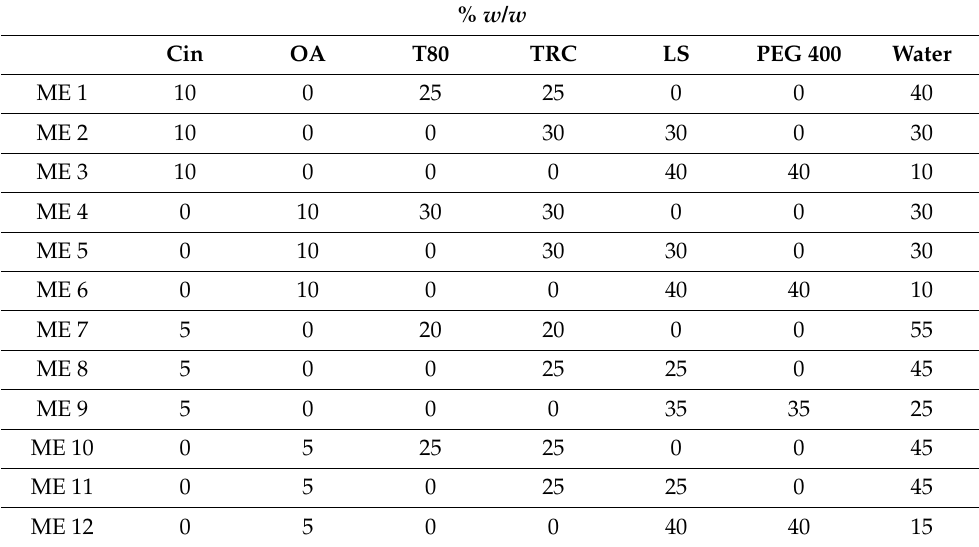
Table 1. Composition of placebo microemulsions used in the